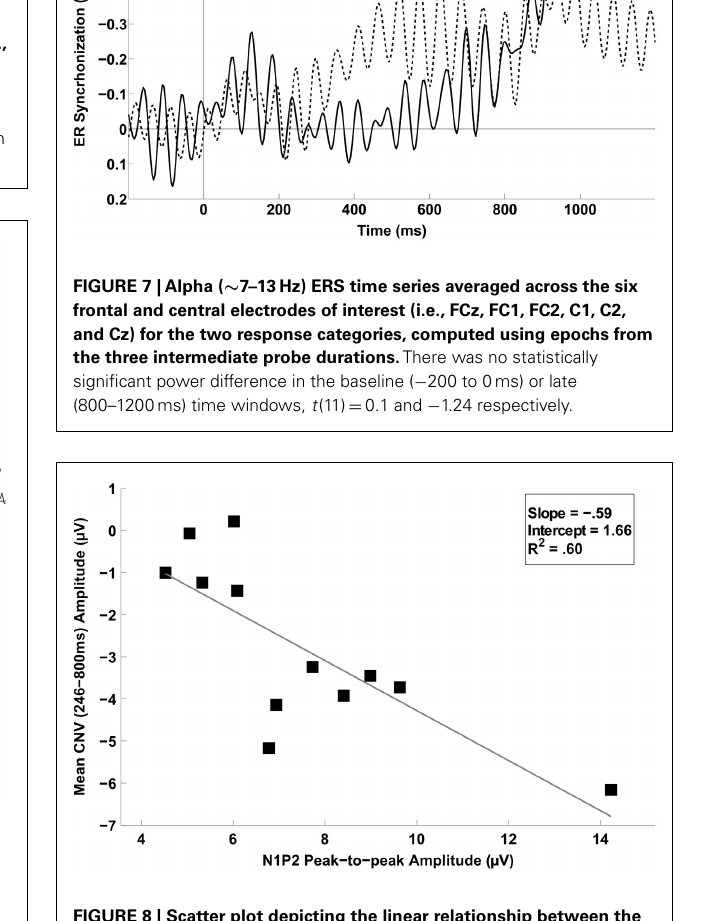
FIGURE 8 | Scatter plot depicting the linear relationship between the mean CNV potential (246–800ms) and the N1P2 amplitude difference (peak-to-peak). Simple regression indicated that larger N1P2 amplitude differences were associated with larger amplitude CNVs.The Pearson correlation coefficient ( r ) was 0.77, and the percentage of variance explained by the regression ( R 2 ) was